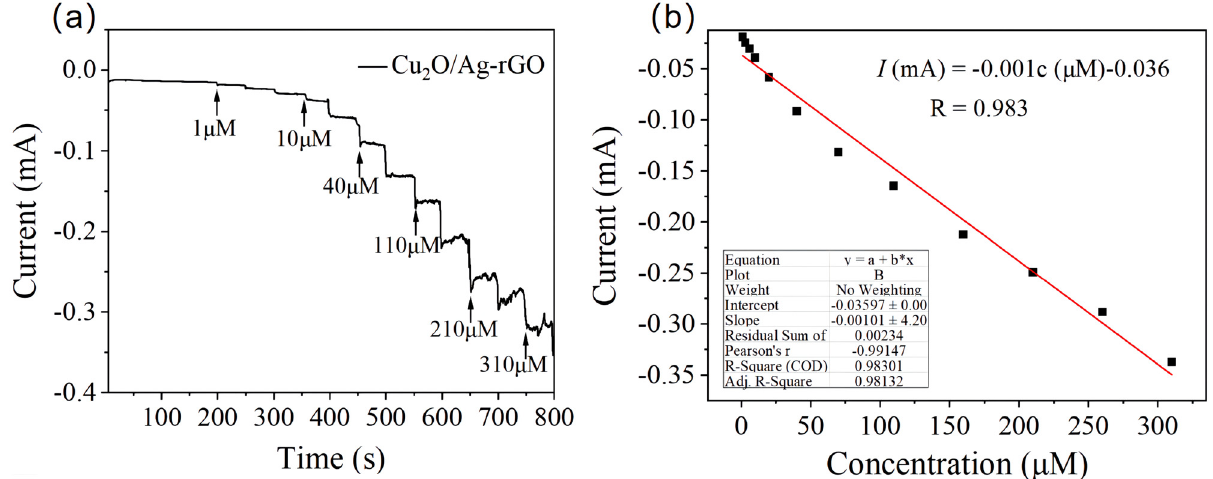
Figure 6: Electrochemical sensing H 2 O 2 : ( a ) i – t response of the Cu 2 O/Ag - rGO nanocomposite - modi fi ed GCE by adding H 2 O 2 with various concentrations, and ( b ) corresponding calibration line of current against the concentration of H 2 O 2